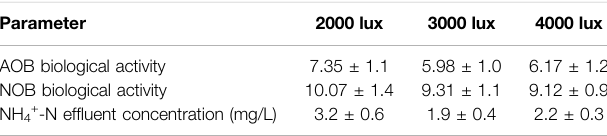
TABLE 1 | Effect of light intensities on the activity of AOB and NOB and NH 4+ -N content. Parameter